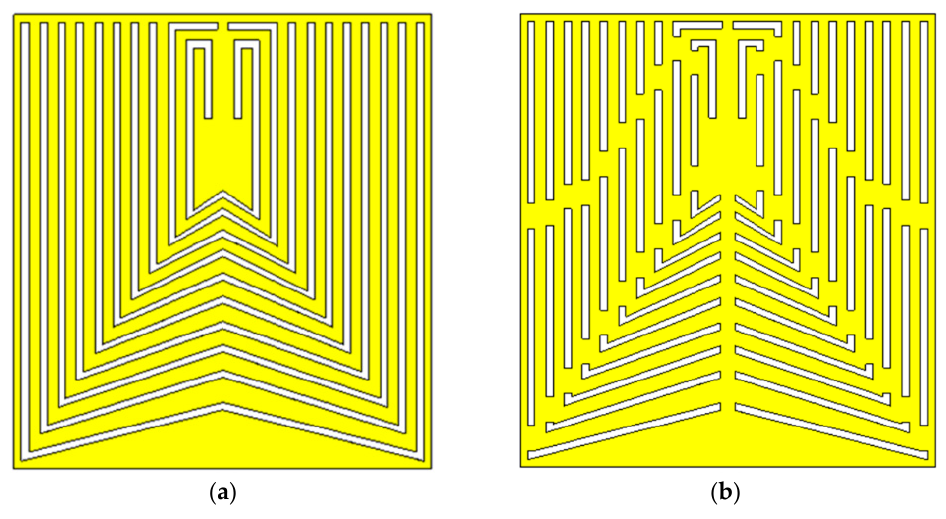
Figure 2. Ten inverted ‐ M chipless RFID tags ( a ) active mode and ( b ) passive mode.